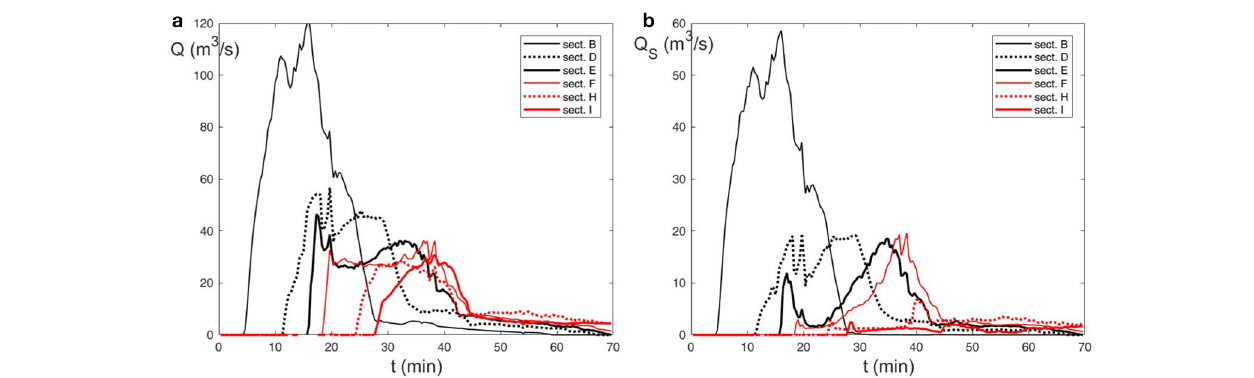
FIGURE 11 | Simulated hydrographs of solid-liquid (a) and solid discharge (b) , Q and Q S respectively, corresponding to the the traces of the six sections of Figure 9